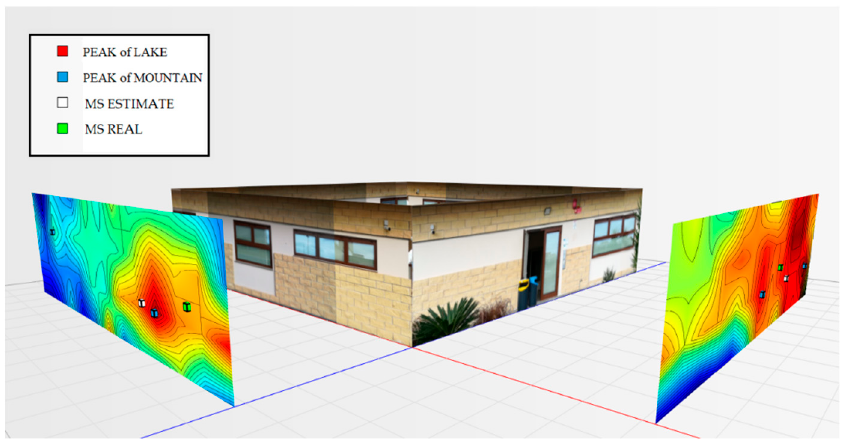
Figure 30. Overview of power levels for walls 1 and 2, room terminal to the right at 1.4 m.